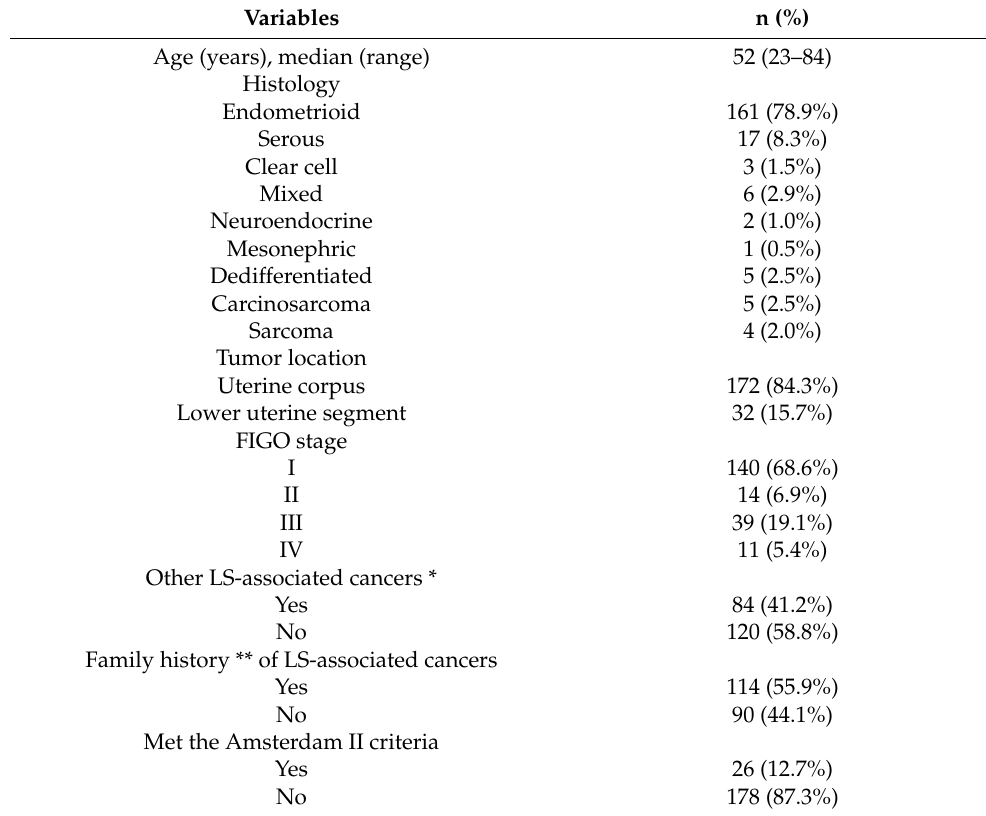
Figure 1. Patient flow chart. Table 1. Clinico-pathological demographics of the endometrial cancer patients (n = 204).